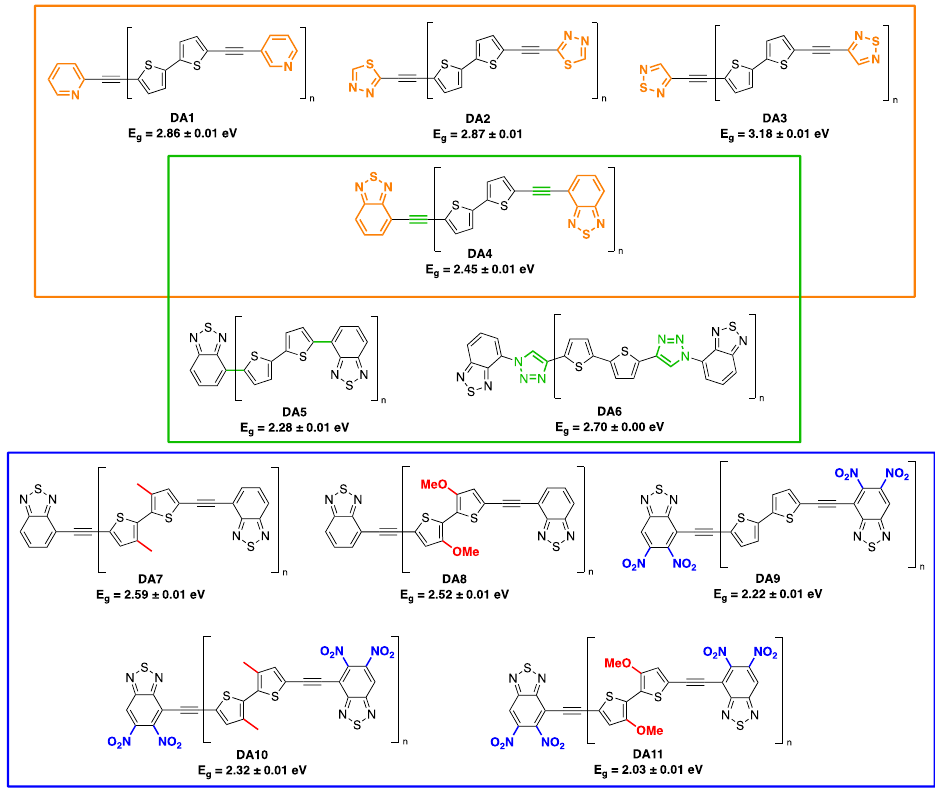
Scheme 1. Calculated bandgaps of various D-A polymer structures differing in acceptor moiety (orange box), linking unit (green box) and substituents (blue box).